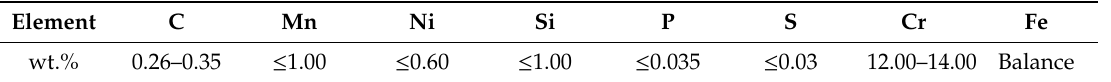
Table 1. Chemical composition of the 3Cr13 stainless steel (wt.%).